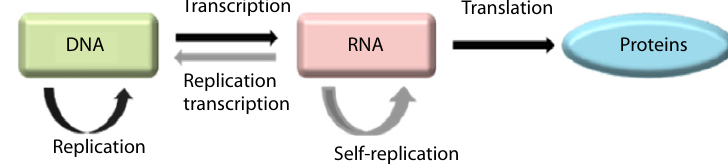
Figure3. Thecentraldogmaofmolecularbiology,asitcurrentlyappliesinmostcells(generaltransfers = black), or under specific conditions (in some viruses and in vitro: special transfers = grey).